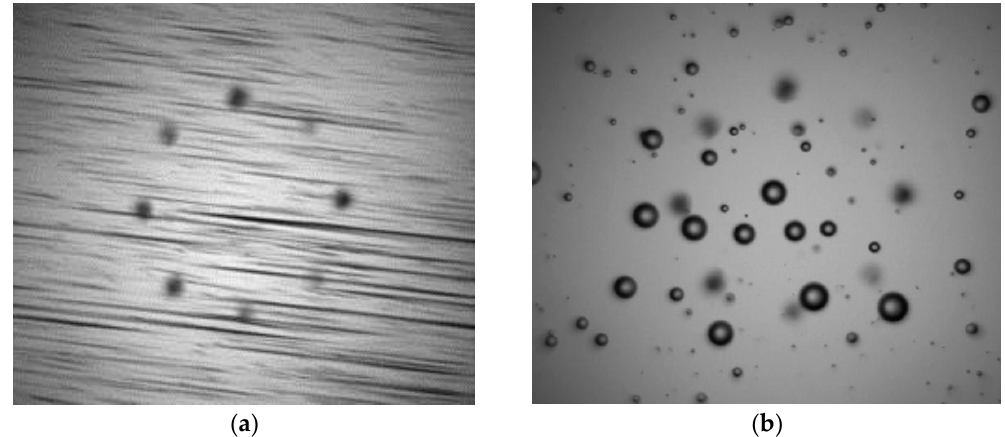
Figure 4. Example of distorted image due to the Rolling Shutter effect recording moving objects suspended in a fluid ( a ). Same objects recorded using synchronized stroboscopic illumination ( b ) generating a non-distorted image. ( a ) image has been recorded using an exposure time of 23 ms and a flash gain of ×1 with a duration equal or longer than the exposure time. The ( b ) image instead uses a flash pulse of 4 µs to allow the smear-free images but requires applying a flash gain of ×40 to achieve a similar image luminance level. In the ( b ) case, the effective exposure time is limited by the flash pulse duration, regardless of the configured pixel exposure.